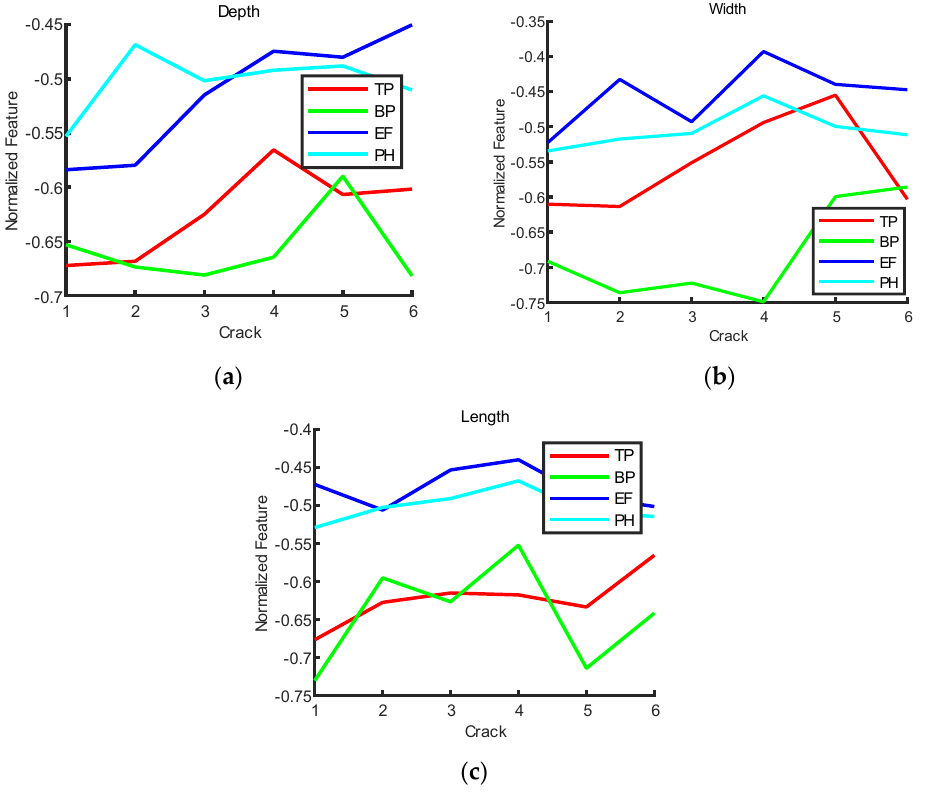
Figure 11 . Carbon steel crack sensing results: ( a ) depth, ( b ) width, and ( c ) length.